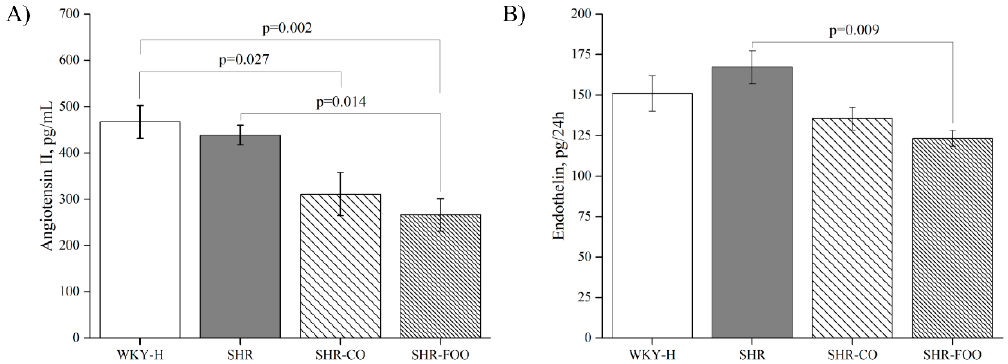
Figure 3. Vasoactive peptide concentrations after EIGHT weeks of intervention: plasma angiotensin II ( A ), urinary endothelin-1 ( B ), and data are mean ± SEM. The ANOVA test and the Bonferroni post hoc were used to compare results among groups. p < 0.05 was considered significant. SHR: spontaneously hypertensive rats. SHR-CO, spontaneously hypertensive rats supplemented with the control olive oil. SHR-FOO, spontaneously hypertensive rats supplemented with the functional olive oil. WKY-H, Wistar Kyoto healthy rats.